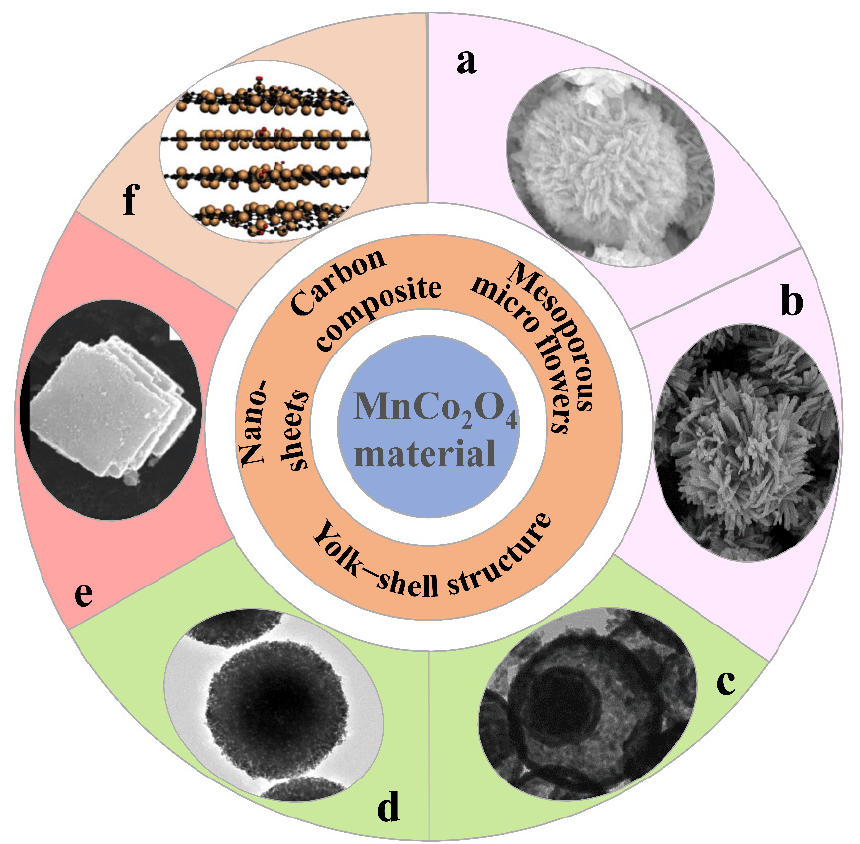
Figure 5. ( a , b ) Mesoporous micro flowers; Reprinted with permission from ref. [48]. Copyright 2016, Elsevier. Reprinted with permission from ref. [61]. Copyright 2015, Materials Letters. ( c , d )